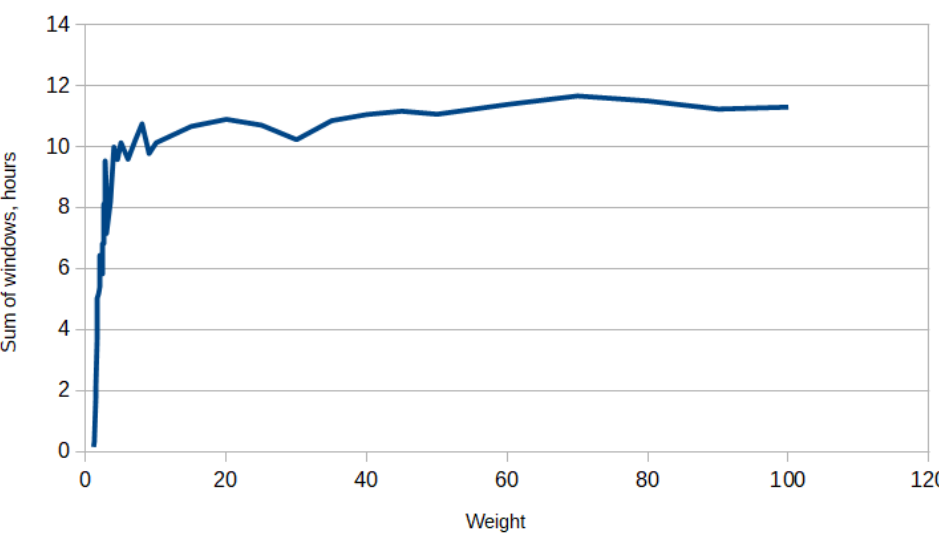
Figure 1. The dependency of the total duration of all schedule gaps on the weight w 0 , 1 ≤ w o ≤ 100.